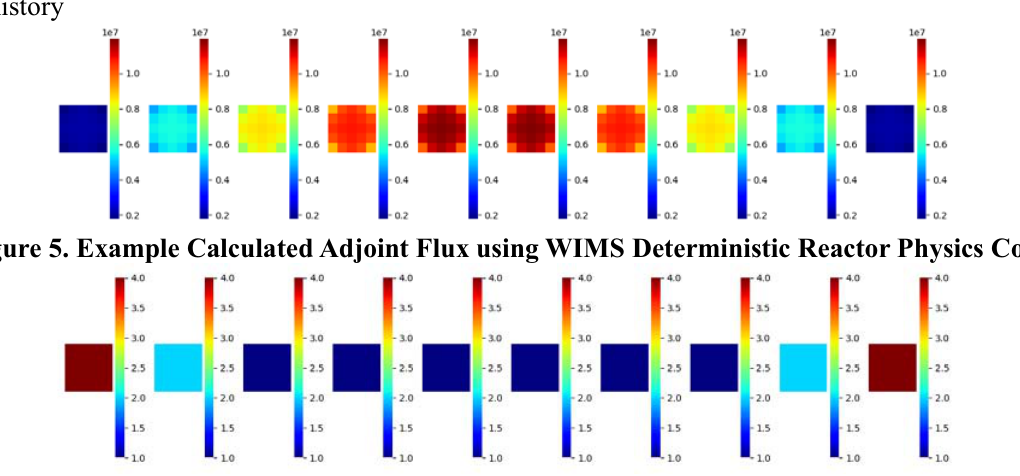
Figure 5. Example Calculated Adjoint Flux using WIMS Deterministic Reactor Physics Code